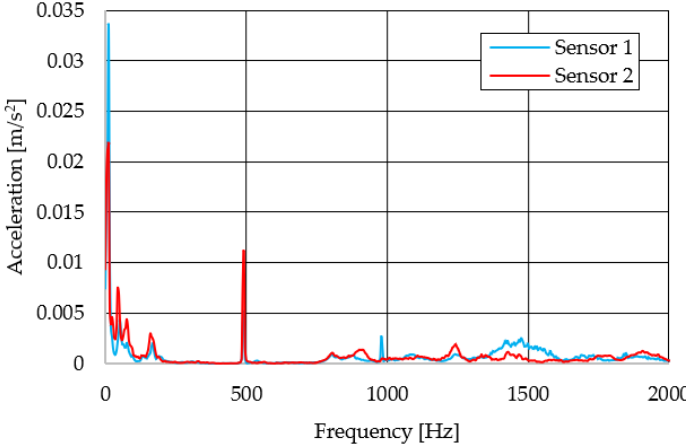
Figure 23. Comparison of the frequency waveforms in the x -axis during asymmetrical crossing over the obstacle by the right wheel.